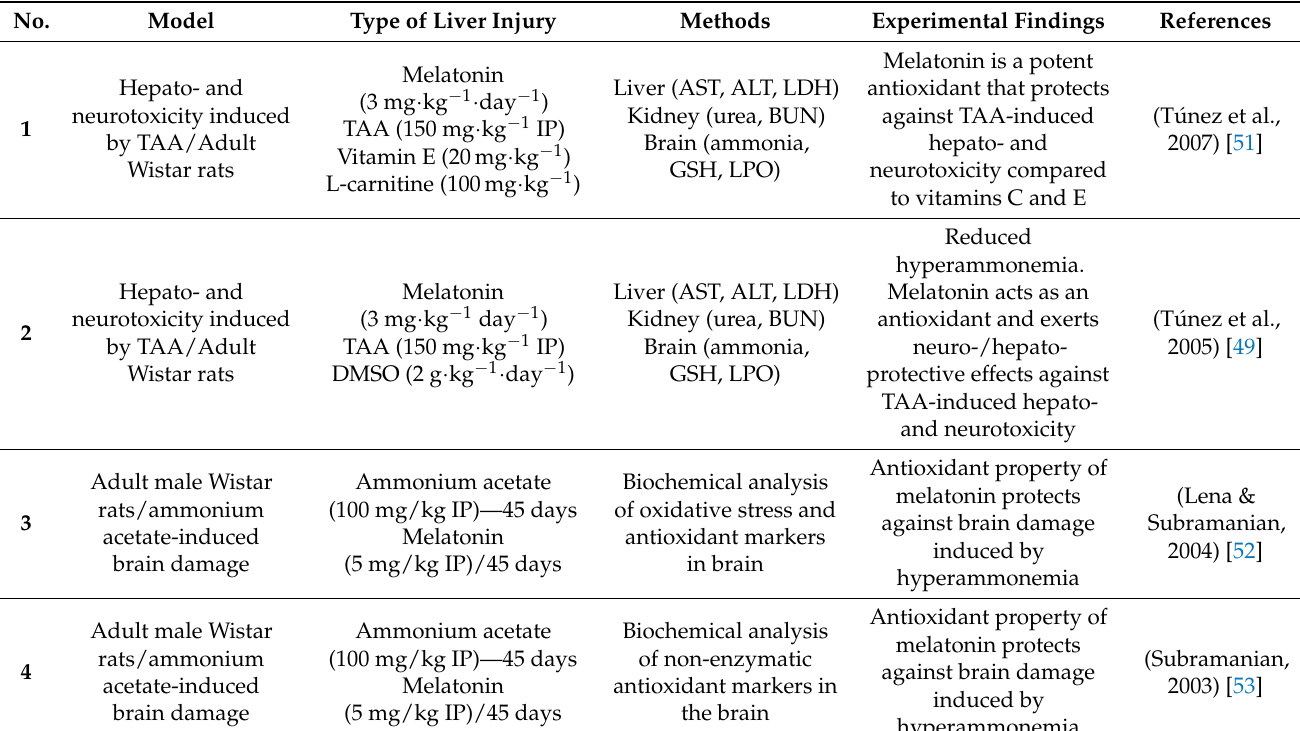
Table 1. Effects of melatonin on